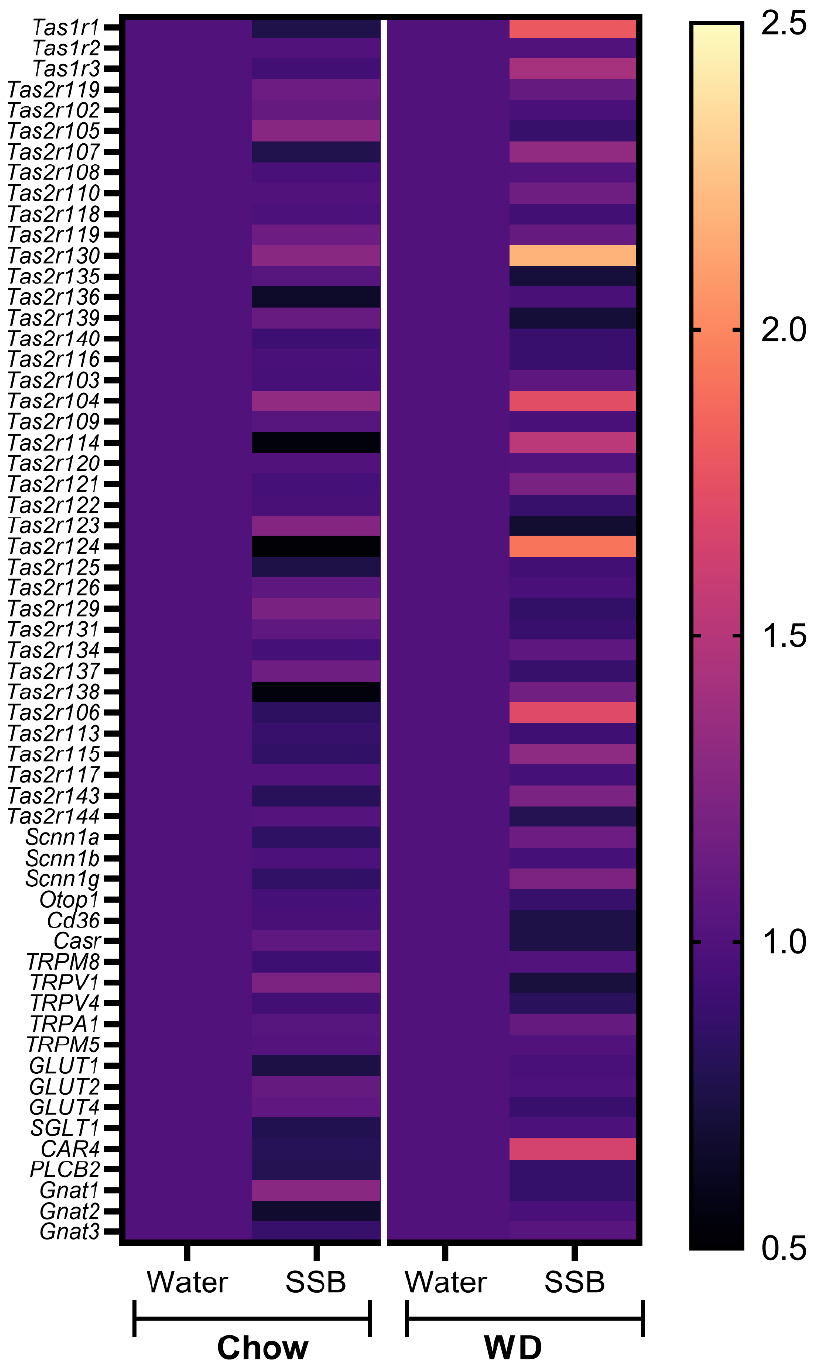
Figure 5. Transcriptome analysis of 59 selected genes associated with oral chemosensation, displayed as a heatmap showing mean fold changes in gene expression of the SSB-fed diet groups in relation to the respective water-fed group (=1) in the form of a color code. The gene expression was analyzed using one customized cDNA microarray per group from pooled RNA samples of the CV from mice that received either a standard diet (chow, n = 10–11) or Western-type diet (WD, n = 7–8) with water (Water) or a sugar-sweetened beverage (SSB) as a drink for 24 weeks .